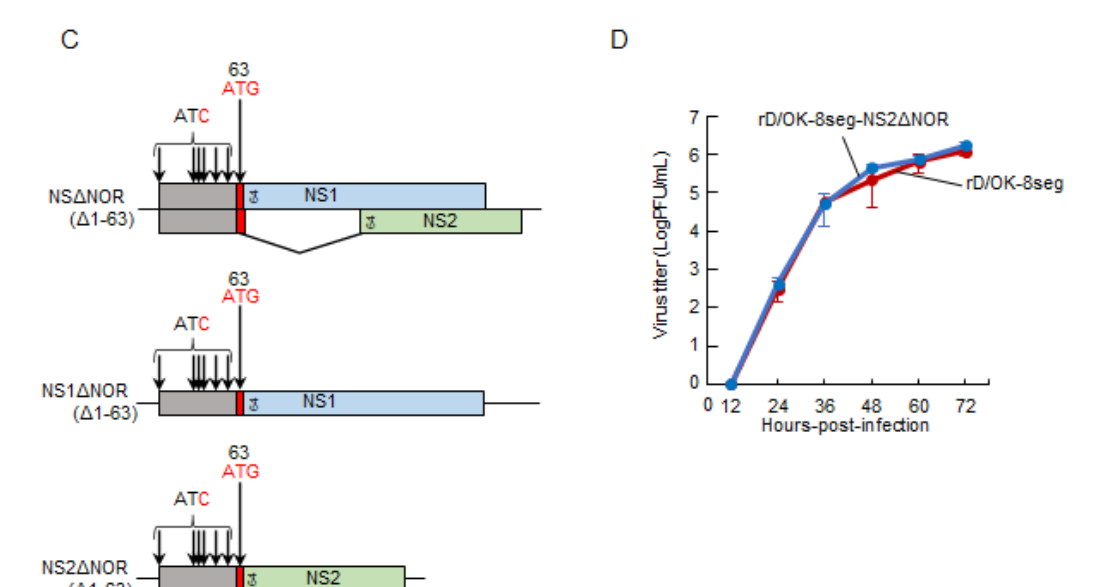
Figure 3. Generation of the rD/OK-8seg mutants with NS partial deletion. ( A ) We created a series of vRNA-synthesis pPol plasmids for the NS2 segment with partial deletions. NOR and specific regions of NS2 are shown in orange and green, respectively. Untranslated regions modified with a start or stop codons are shown in gray. Each number indicates the codon position from the first ATG, and the red letters indicate the substituted nucleotides. Dashed lines indicate the deleted regions. ( B ) vRNA-synthesis plasmids for each NS2 segment with partial deletion were co-transfected with the other 7 (PB2, PB1, P3, HEF, NP, M, and NS1) segment vRNA-synthesis plasmids and 4 protein (PB2, PB1, P3, and NP)-expression plasmids into HEK293T cells. Thereafter, the supernatant was inoculated into ST cells. CPEs were observed on ST cells following inoculation of the transfectant with pPol-NS2 ∆ 1-26, ∆ 27-46, or ∆ 47-63, but not with the other 6 plasmids with deletions. Both NS1 and NS2 segments were detected by RT-PCR in the supernatants of ST cells showing CPEs with 1% agarose gel electrophoresis. The results of virus rescue were indicated at the bottom of the figure: rescued (+) or not rescued ( − ). ( C ) We created NOR-deleted NS, NS1, or NS2 segment by introducing mutations at all ATG codons within NOR and adding a start codon (ATG) at the 63rd position. Untranslated region by this modification, NS1-, and NS2-specific regions are shown in gray, blue, and green, respectively. Inserted start codon and the substituted nucleotides are shown in red. Each number indicates the position of the codon. The 8-segmented rescue system indicated that only rD/OK-8seg-NS2 ∆ NOR could be rescued. ( D ) Growth kinetics of rD/OK-8seg-NS2 ∆ NOR and rD/OK-8seg was assessed in ST cells (MOI of 0.0001). Viral titers were determined at 12 h intervals post-infection by the plaque assay and reported as the mean titer with standard deviations ( n = 3). ANOVA (a linear mixed model) indicated no significant differences in growth kinetics between the two viruses.